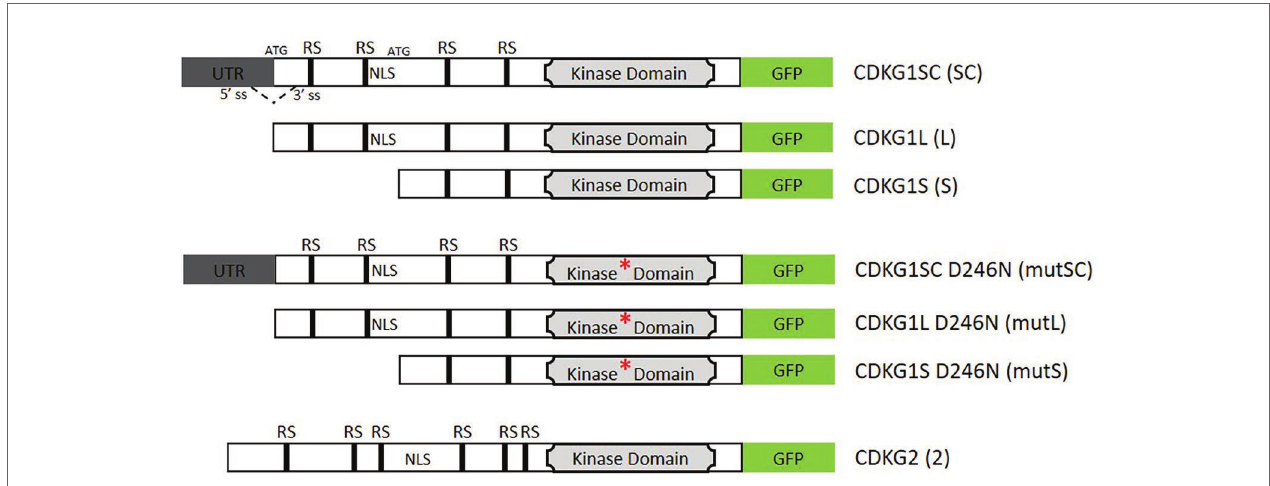
FIGURE 1 | Schematic representation of the constructs used in this study. The coding region is represented by the open box and the 5 ' UTR in gray. The GFP coding sequence in shown green. The kinase domain is depicted by a light gray box and the asterisk indicates the D426N mutation of the kinase active site. Arginine/Serine rich motifs (RS) and indicated by black boxes, (NLS, nuclear localization signal). The splicing donor (5 ' SS) and acceptor sites (3 ' SS) and the two possible start codons (ATG) are indicated in the splice competent (SC) form. The dashed line indicates the potential splicing event. In the absence of splicing, the first ATG is used and the long (L) form produced, if splicing occurs then only the second ATG site will be present and only the short (S) form can be produced. The represented cassettes were cloned under the control of the cyclin-dependent kinase G1 (CDKG1) promoter unless otherwise stated and transformed into a cdkg1-1 or Col-0